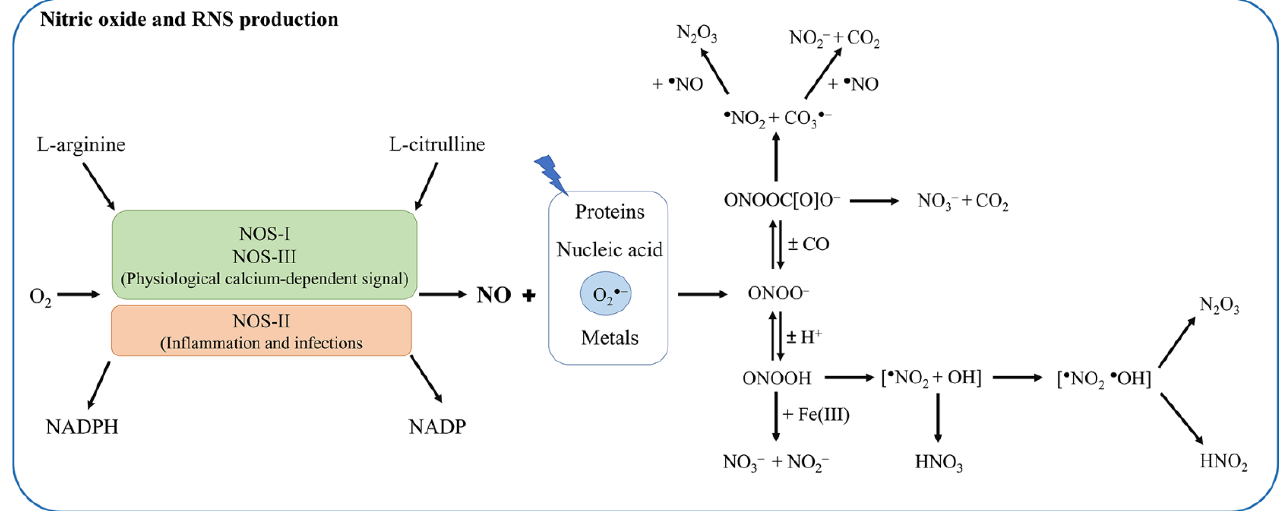
Figure 1. Overview on NO and reactive nitrogen species (RNS) production. NO can be produced from the oxidation of L-arginine in the presence of O 2 , NADPH, and various co-factors. This reaction is catalyzed by the constitutive NOS-I (nNOS) and NOS-III (eNOS) enzymes, as well as by the inducible NOS-II (iNOS). Once produced, NO can interact with O 2 , metals, nucleic acids, and proteins as well as with O 2 •− , generating peroxynitrite (ONOO − ). ONOO − reacts with CO 2 to form 1-carboxylato-2-nitrosodioxidane (ONOOC[O]O − ), which decays by homolysis of the O–O bond to yield the reactive species nitrogen dioxide ( • NO 2 ) and trioxocarbonate (CO 3 •− ).